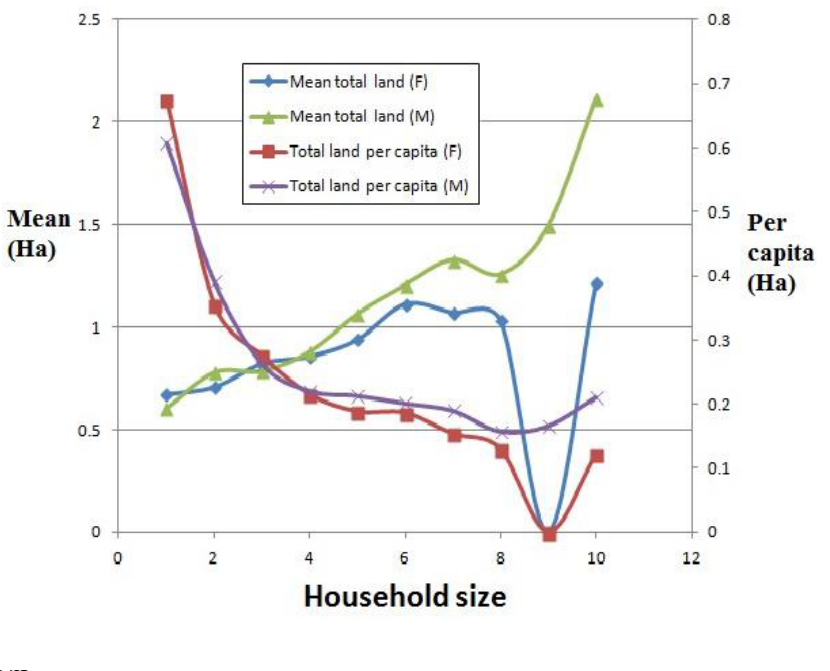
Figure 6. Mean total land and total land per capita distribution per household size by gender of head of household in Malingunde EPA. Note: M = Male; F =